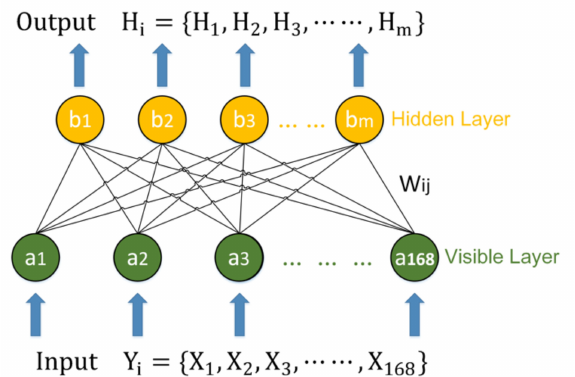
Figure 2. The network structure of Restricted Boltzmann Machine (RBM)